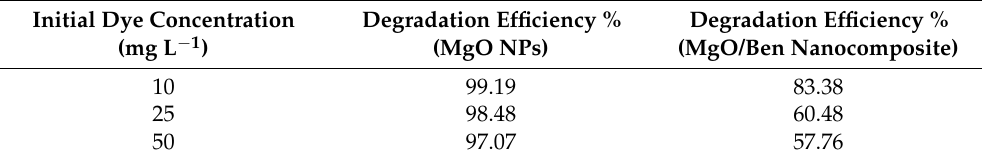
Table 4. The degradation efficiency of CV using MgO NPs and MgO/Ben nanocomposite at different initial dye